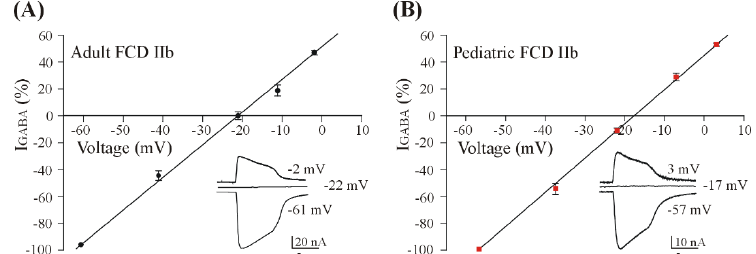
Figure 2. GABA reversal potential in FCD IIb tissue samples. The two panels represent the mean E GABA value recorded on adult ( A ); black circles; n = 10, # 4–6, Table 1) and pediatric ( B ); red squares; n = 13, # 1–3, Table 1) FCD samples. The dots represent mean ± s.e.m. of GABA currents at correspondent holding potential value (V H ) normalized to the maximum currents (I max = 73.4 for adult and 42.4 nA for pediatric). Insets represent sample GABA − evoked currents (250 µ M) at different V H as shown in the respective panels. Note that the mean E GABA was significantly more depolarized in pediatric FCD tissues compared to adult FCD ( p < 0.05, Wilcoxon signed rank test).